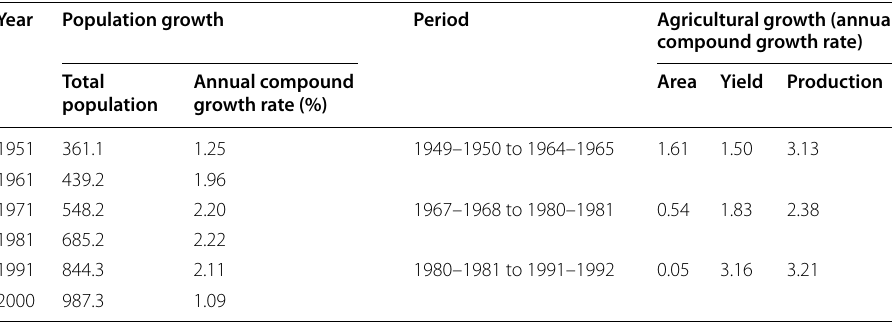
Table 1 Population growth versus agricultural growth. Source : Agricultural Statistics at a Glance, GOI, New Delhi, 1993